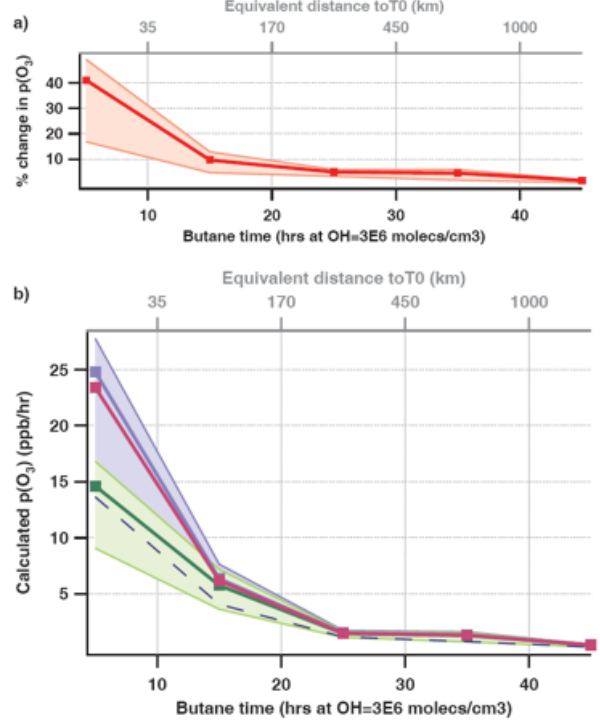
Fig. 8. (a) The median percent decrease in the calculated P (O 3 ) as a result of including 6 ANs formation with the observed average nitrate branching ratios. The borders of the shaded region represent the 1 σ variation of the data. (b) The absolute ozone production rate calculated using Eqs. (7) and (8) with no nitrate formation (blue), with nitrate formation using the branching ratio calculated using the MCM mechanism as shown in Table 1 (magenta) and with nitrate formation using the branching ratios inferred from observed slopes of 6 ANs vs. O x in the Mexico City plume (green). Again, the shaded area represents the spread of the data from the 1 σ variation of the